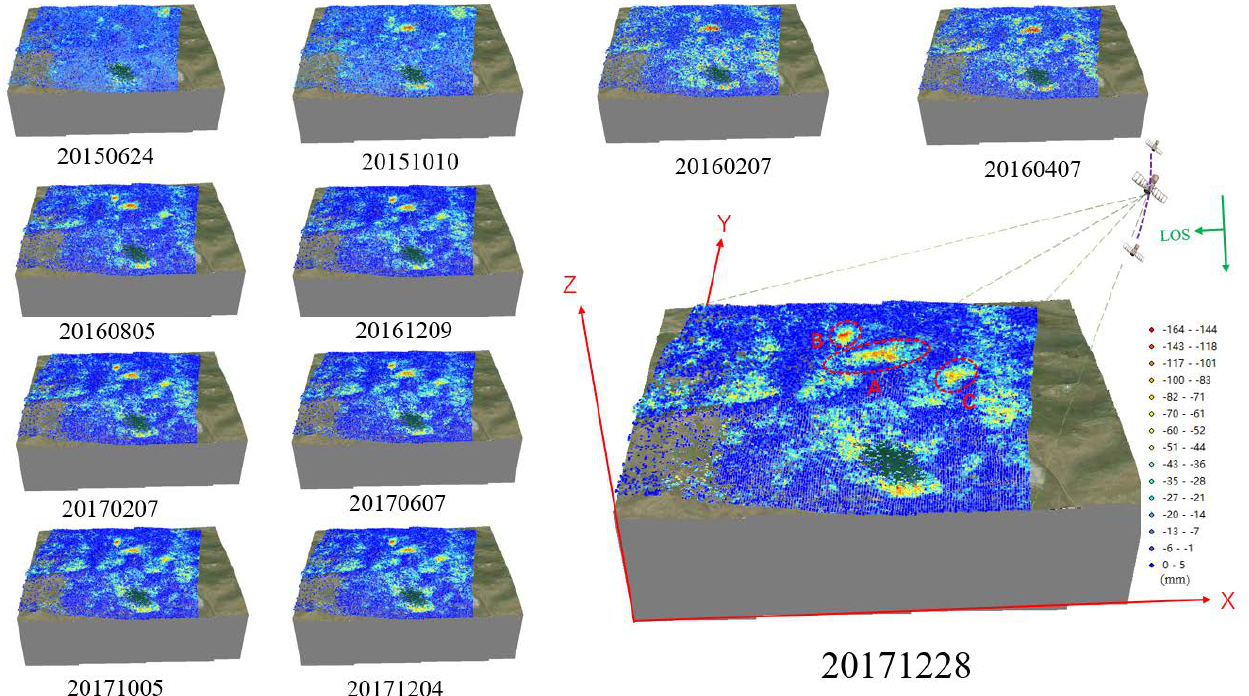
Figure 4. Cumulative